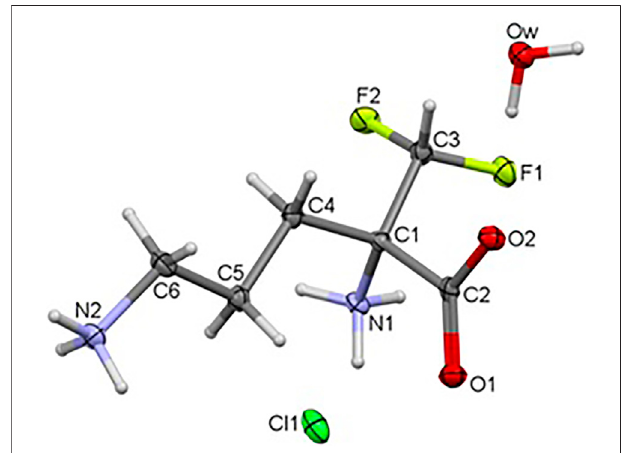
FIGURE 2 | Crystal structure of the title compound 1